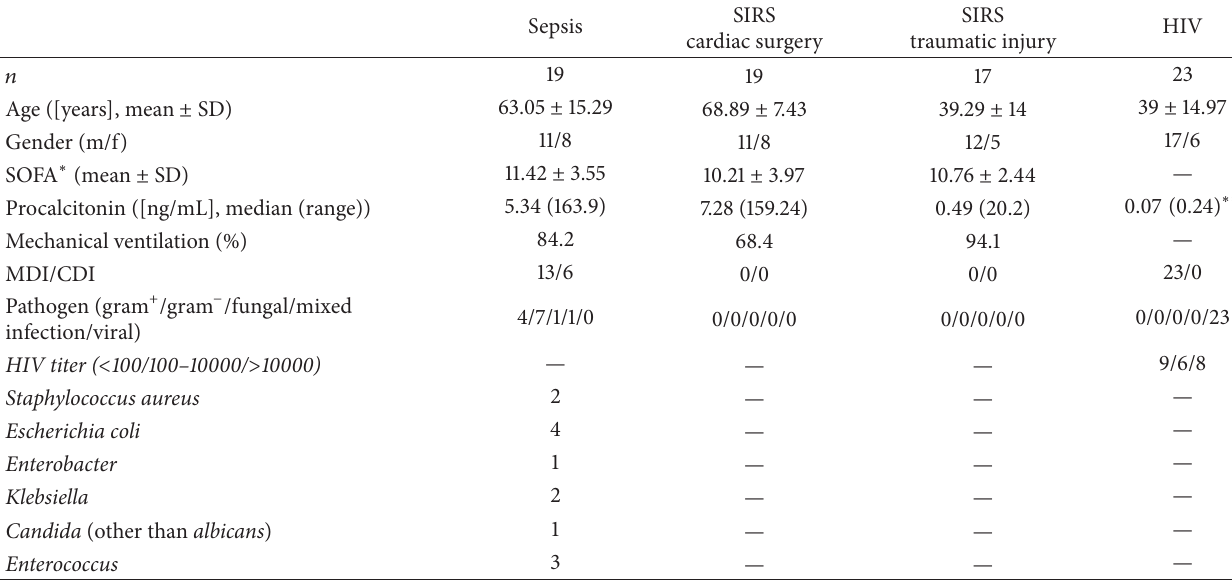
Table 1: Patient characteristics.